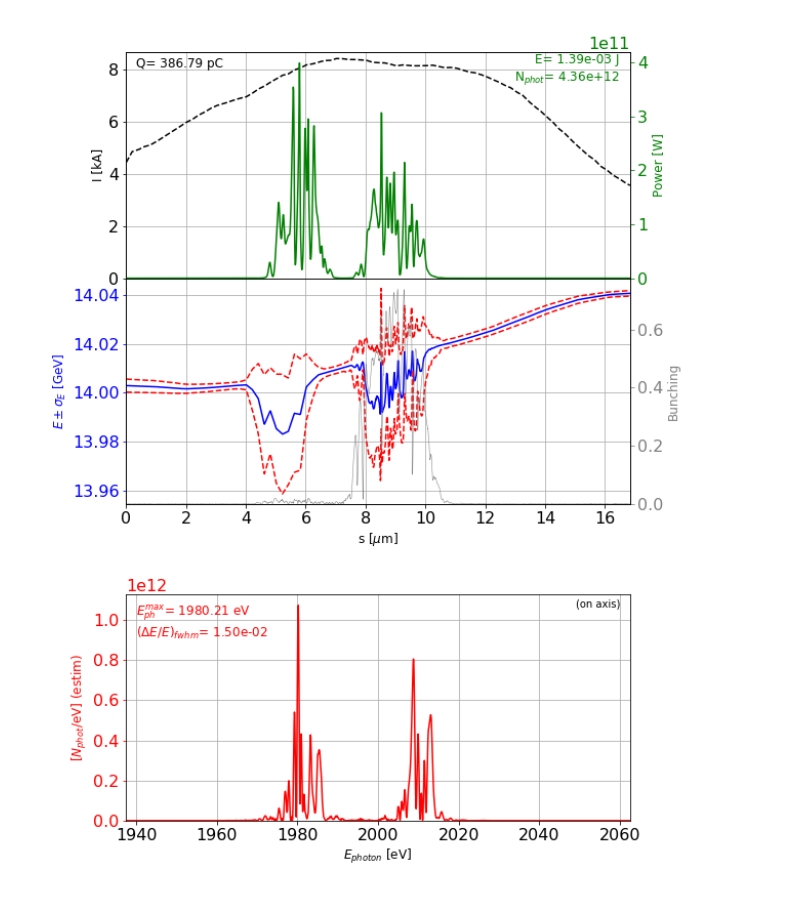
Figure 11. Simulated radiation and electron beam properties at the end of U2 for the fresh-slice technique. Top subplot: electron beam current (dashed black line) and radiation power (green line). Middle subplot: mean electron beam energy (blue line), energy spread ± σ (area within the dashed red lines) and density modulation factor—bunching—(gray line). Bottom subplot: on-axis radiation spectrum. The head of the beam is located on the right, and emits after the tail with a photon energy of 1980